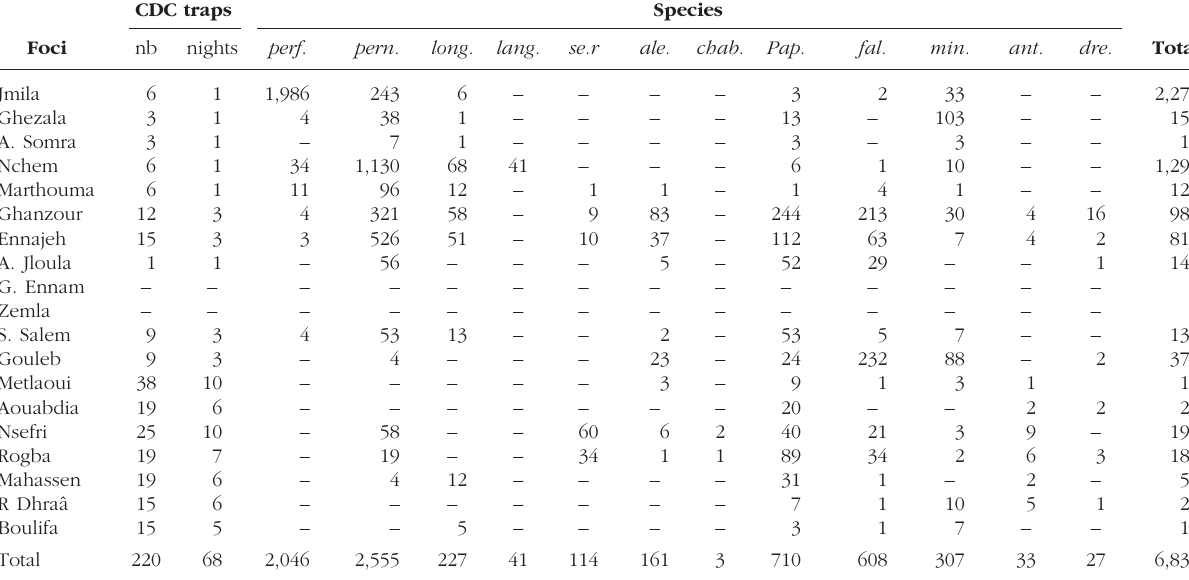
Table Ia. – Distribution of phlebotomine species caught by CDC traps in the studied leishmaniosis sites.